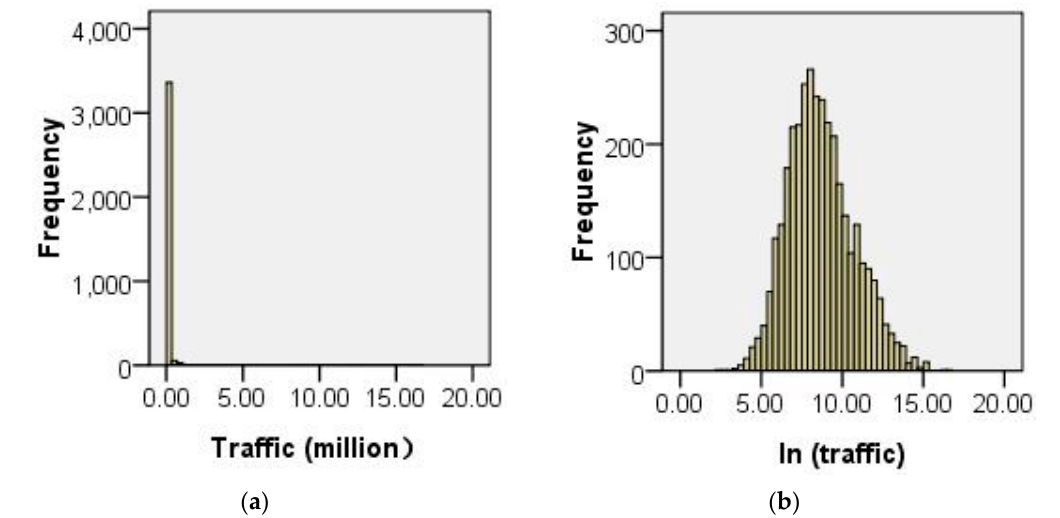
Figure 5. Traffic flows at county level. ( a ) Histograms; ( b ) log-transformed values. Figure 5. Tra ffi c flows at county level. ( a ) Histograms; ( b ) log-transformed values.